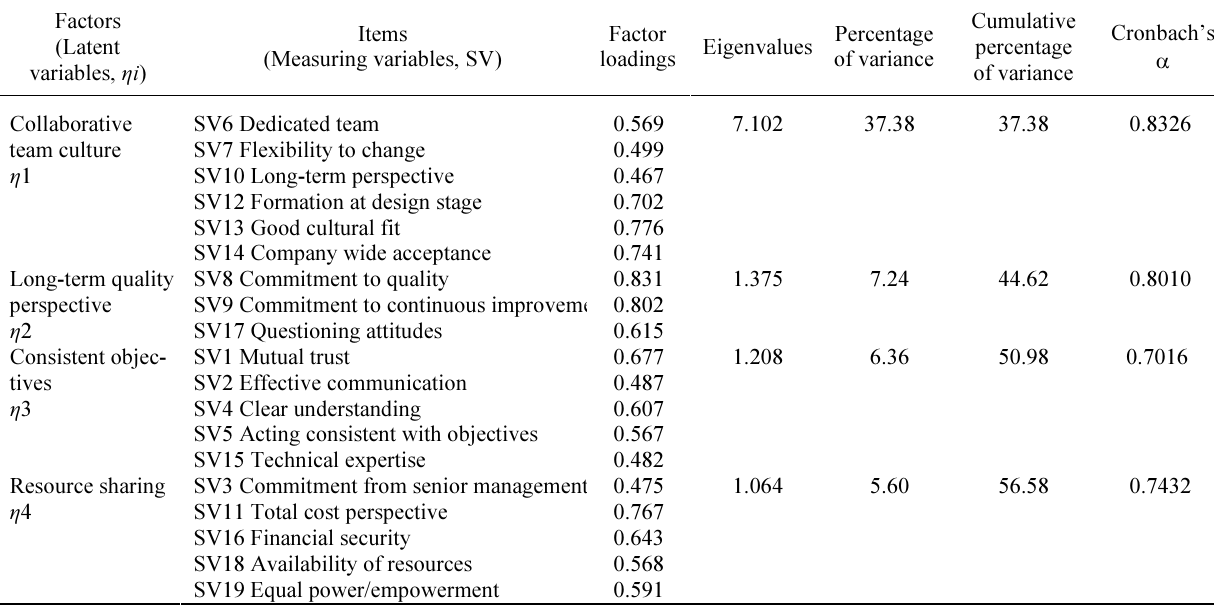
Table 5. Principal components analysis on success variables and reliability testing of initial